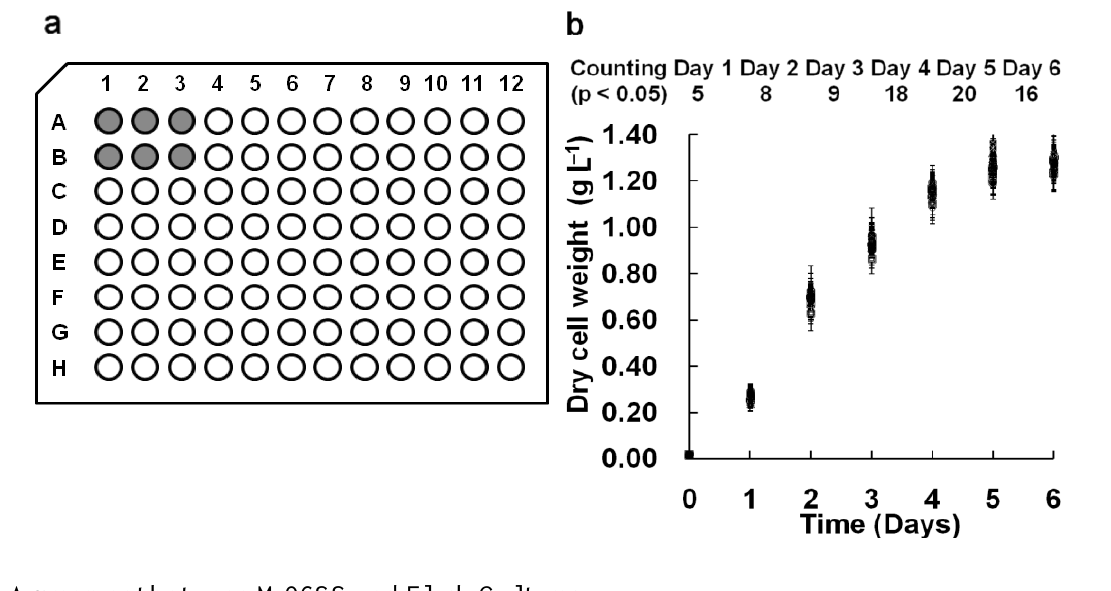
Figure 2. Consistency of parallel samples in M96SS. ( a ) The division of parallel samples. Each sample consisted of 6 continuous replicates; ( b ) The growth curves of Chlorella pyrenoidosa SJTU-2 inoculated at 0.02 g L −1 cultivated in M96SS with 0.8 L −1 d −1 CO 32 parallel samples from two microplates. The culture was illuminated at 180 μmol m −2 s −1 at 25 ±